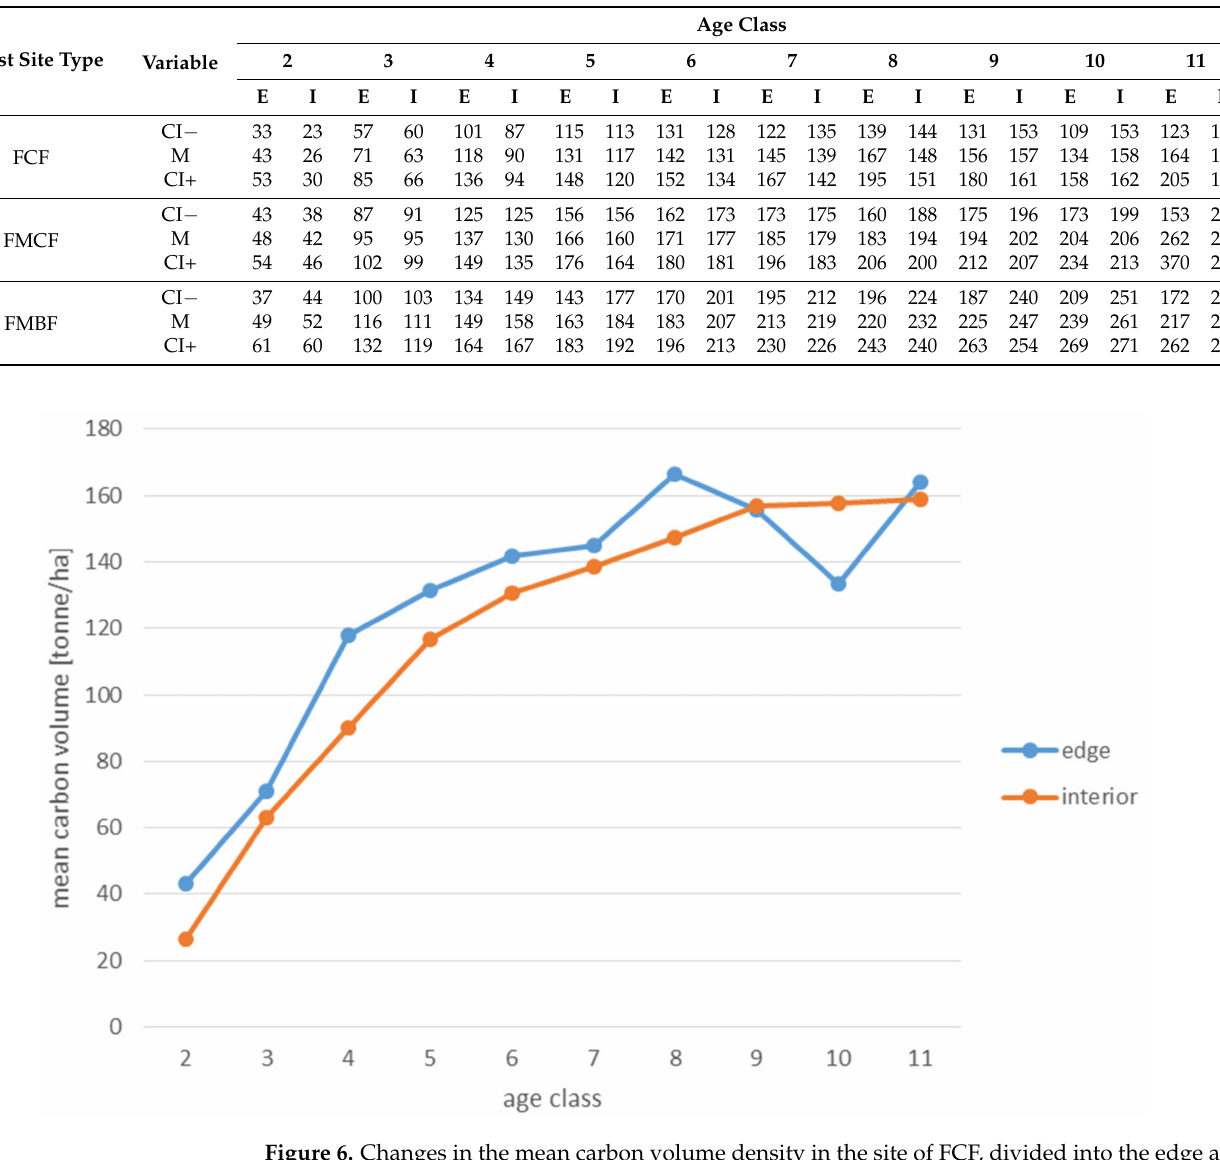
Table 6. Mean (M) volume of carbon (tonne/ha), with confidence intervals (CI) in the edge (E) and in the interior (I).